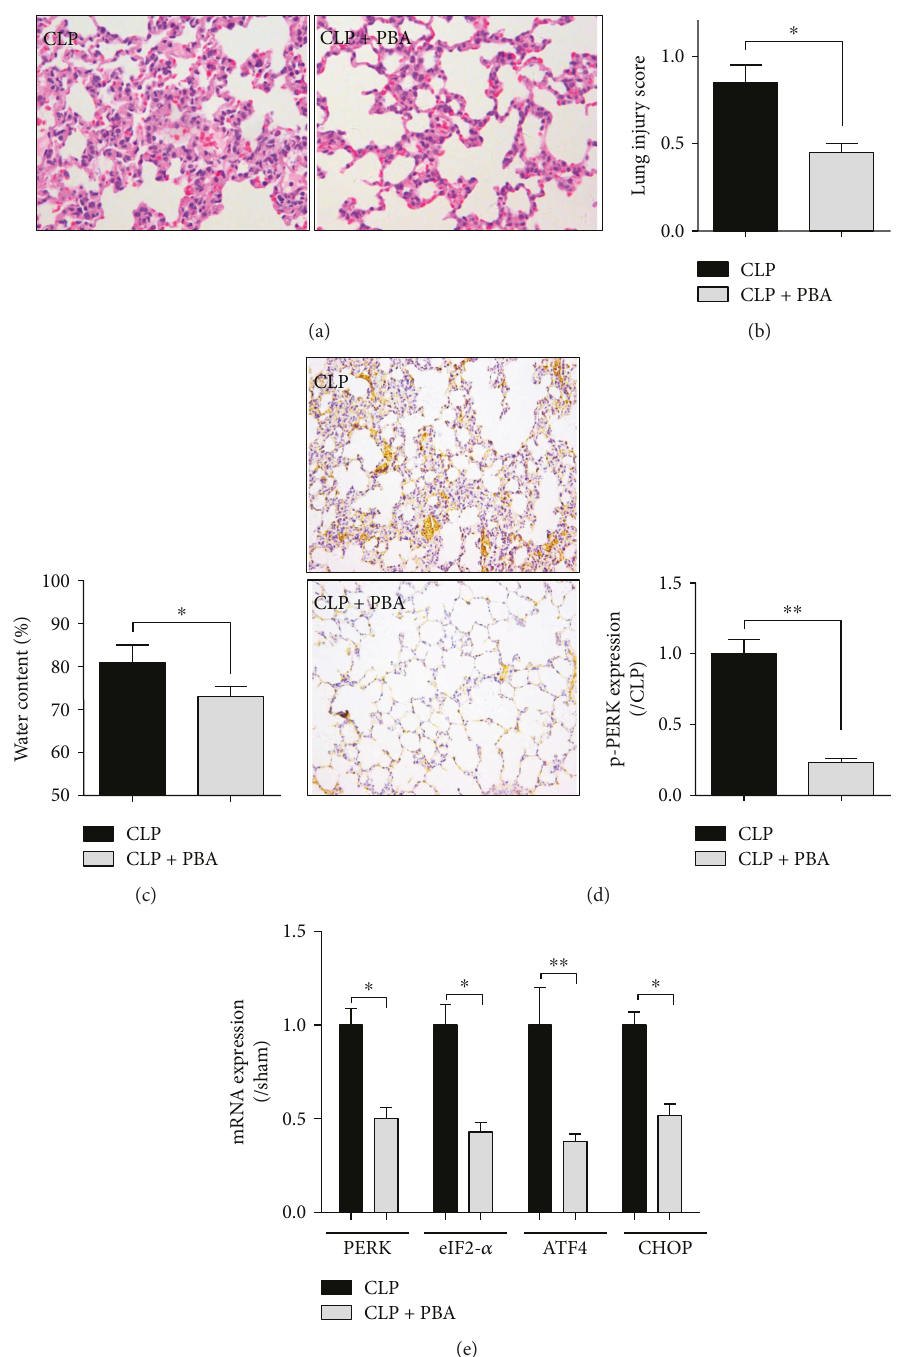
Figure 2: Inhibition of endoplasmic reticulum stress could reduce lung injury in sepsis animals. Sprague-Dawley rats were injected intraperitoneally with 4-PBA (40mg/kg) 30 min before CLP, and lung samples were collected 18h following CLP. (a) Lung pathology was detected by using hematoxylin and eosin (H&E) staining. (b-c) Levels of lung injury score and water content in lung tissues. Lung injury score (b) evaluation was due to the pathology, and levels of the water content (c) in lung tissues were analyzed by using W/D method. (d) The expression of p-PERK protein was assayed by immunohistochemical technique. (e) Levels of endoplasmic reticulum stress-related genes, that is, PERK, eIF2- α , ATF4, and CHOP, were detected using real-time (RT) PCR method. PBA, 4-PBA. Data are shown as mean ± SEM ( n = 6 ). ∗ P < 0 05 and ∗∗ P < 0 01 ; one-way ANOVA Tukey ’ s post hoc